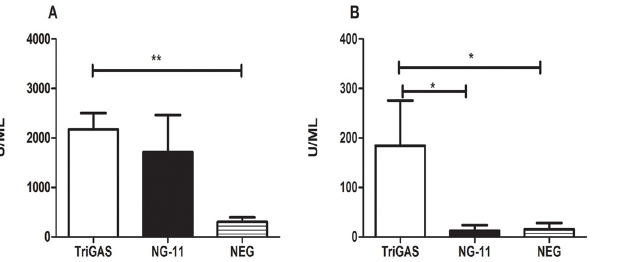
Quantification of anti-G antibodies in the serum by ELISA.